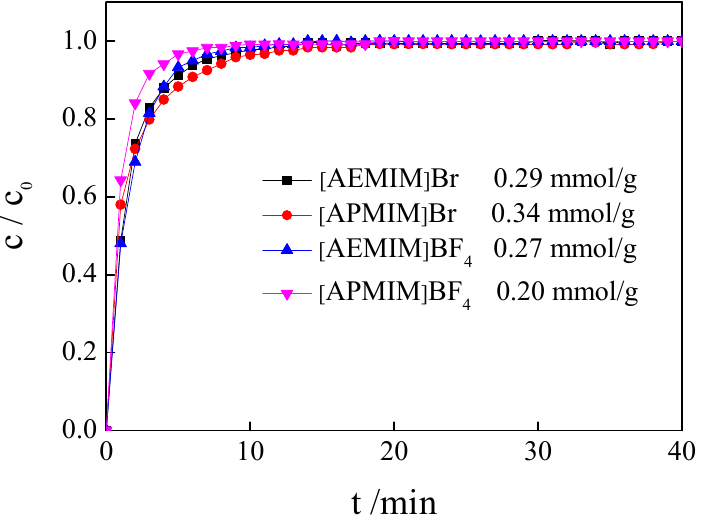
Figure 4. CO 2 adsorption curves and CO 2 capacity of different modified magnesites (3 g adsorbent, 10% loading amount, 100 mL/min flow rate, 50 °C and 0 MPa; c–CO 2 monitoring concentration, c 0 – CO 2 initial concentration, the same in the following figures). Table 1. CO 2 adsorption capacity of magnesite modified under different conditions (10% CO 2 ). Ionic